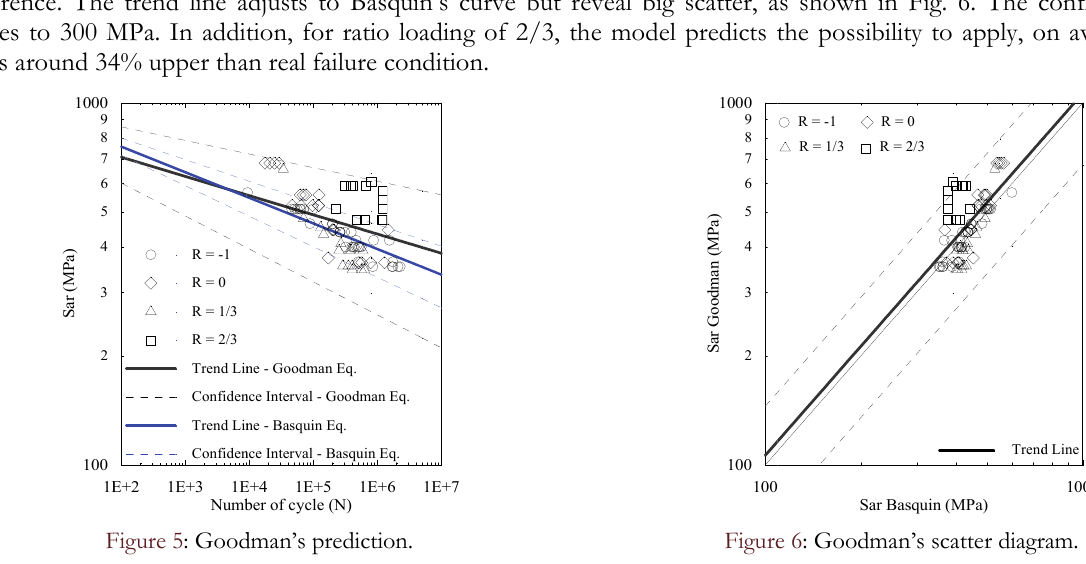
ental results: xperimental d adjusts to